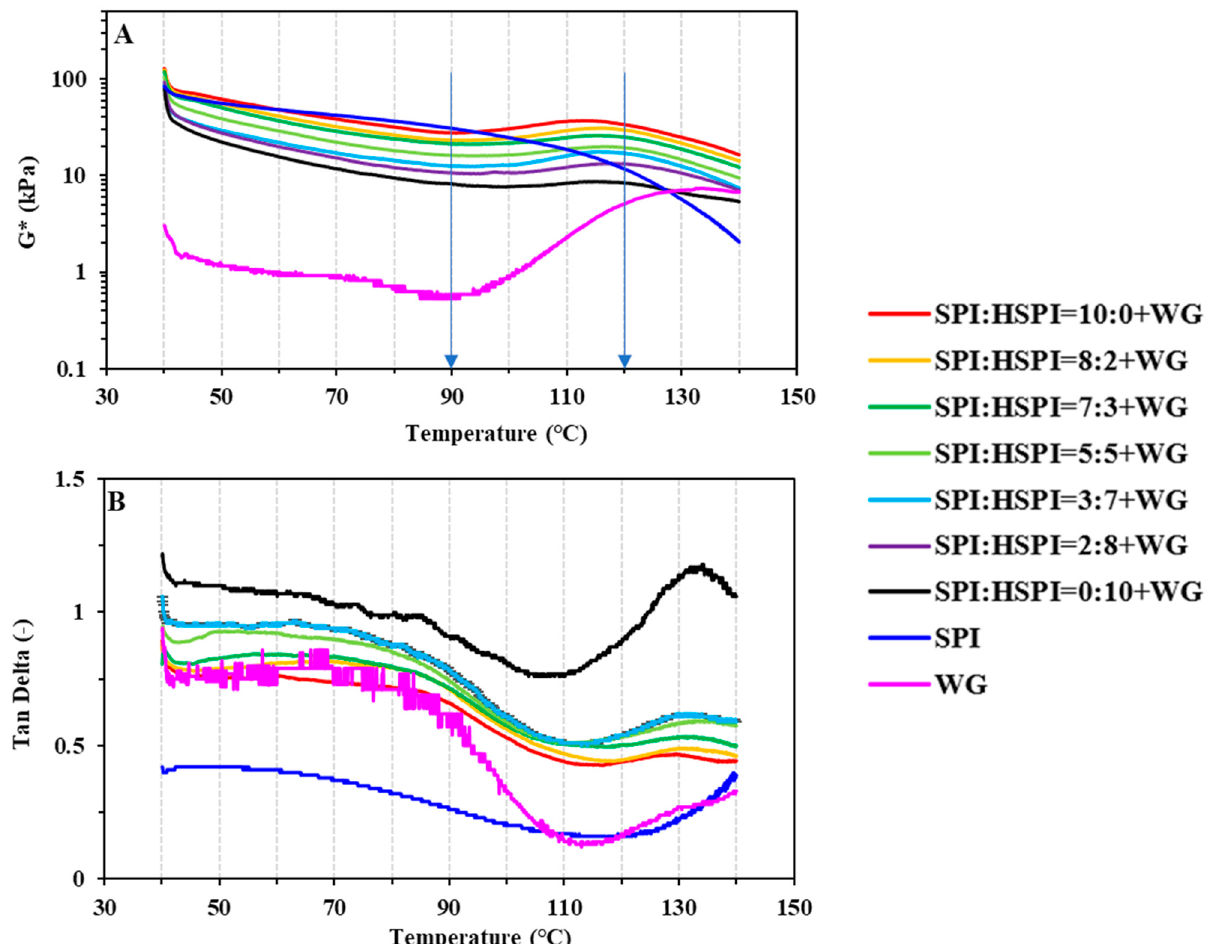
Figure 4. Complex modulus (G*) and tan δ as a function of Soy protein mixture-WG blends, SPI, and WG were shown in ( A ) and ( B ), respectively. From 40 °C to 140 °C, the temperature was increased at a rate of 5 K/min. Constant frequencies and strain (10 Hz and 80%, respectively) were used. The two arrows guide the eye to compare under different temperatures.